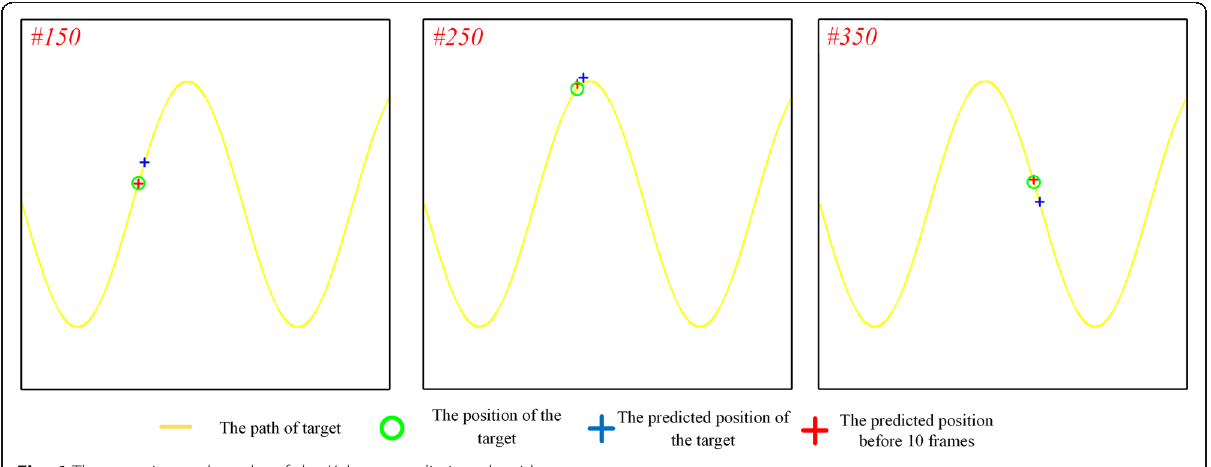
Fig. 6 The experimental results of the Kalman prediction